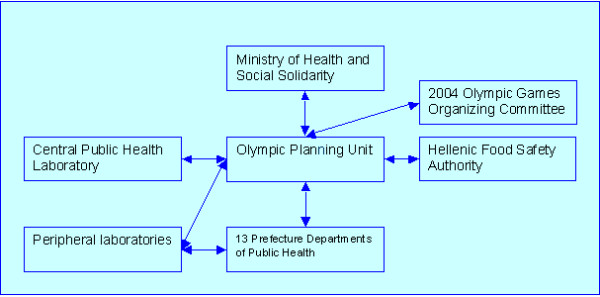
Communication flow chart of the environmental health surveillance and response system for the 2004 Olympic Games.